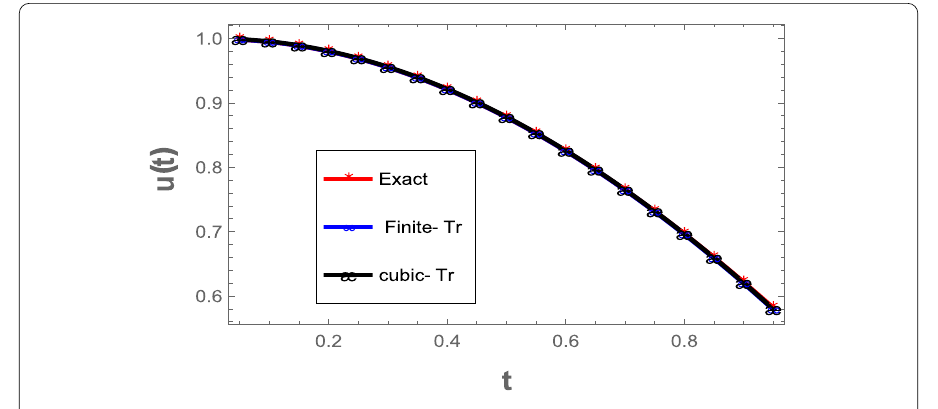
Figure 2 Comparison between the numerical and exact solutions of Test problem 2